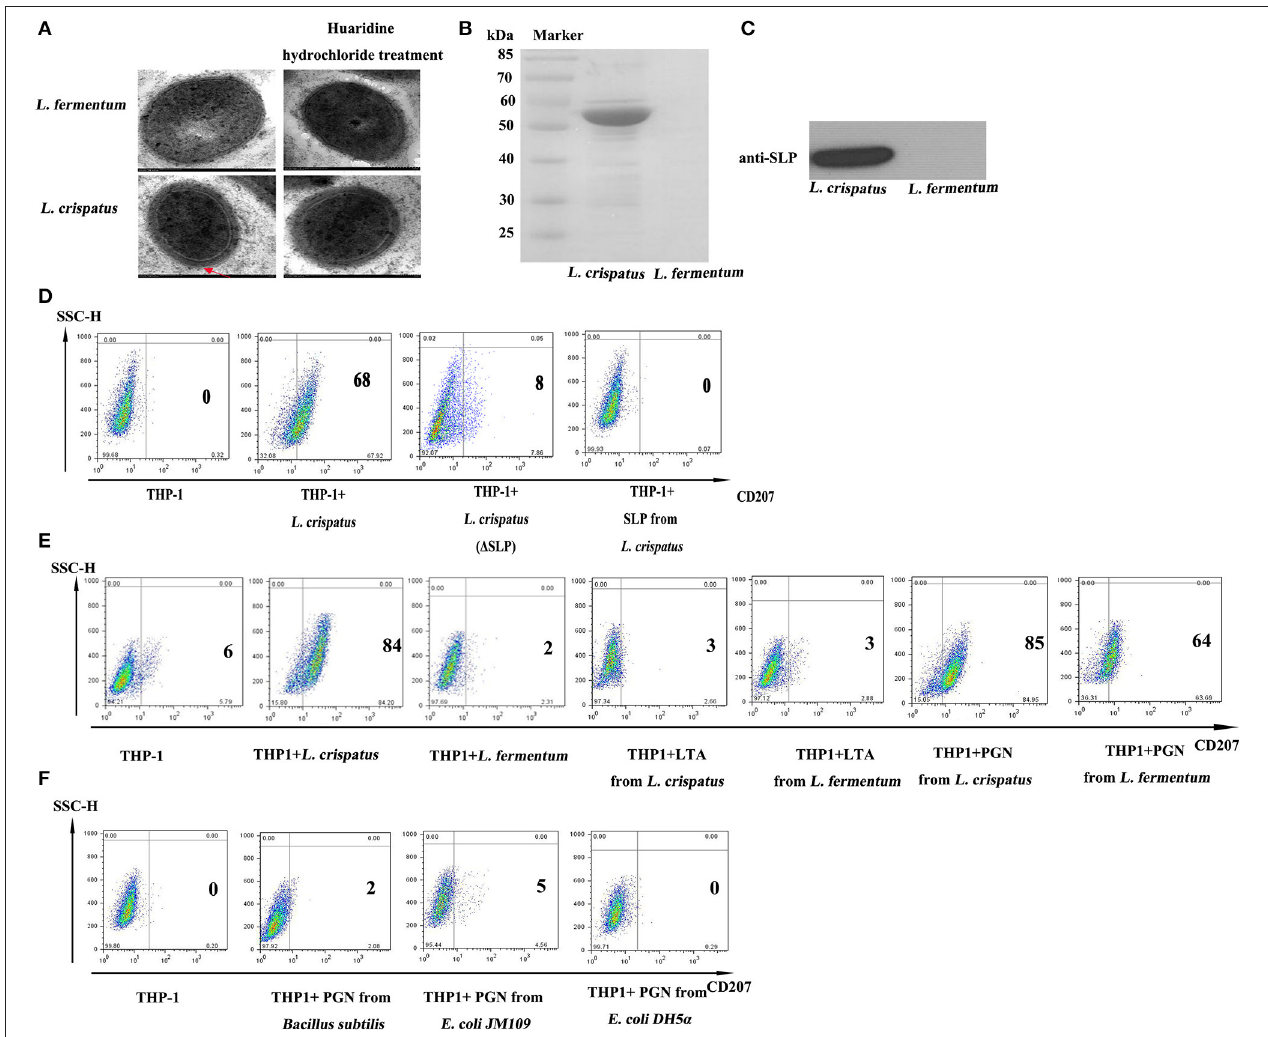
FIGURE 7 | The function of SLP, f PGN and LTA in regulating the expression of CD207 on THP-1. (A) The structure of L. crispatus and L. fermentum were observed by transmission electron microscopy (TEM). L. crispatus and L. fermentum untreated and treated with huaridine hydrochloride were observed by TEM with high magnification. (B) Detection of SLPs from L. crispatus and L. fermentum by SDS-PAGE. (C) Identified SLPs from L. crispatus and L. fermentum by WB. The target protein is about 55 kDa. (D) CD207 expression induced by SLP from L. crispatus. Cells were treated with 1 mg/ml SLP from L. crispatus and L. fermentum . (E) CD207 expression induced by PGN and LTA from L. crispatus and L. fermentum . Cells were treated with 1 mg/ml PGN or LTA from L. crispatus and L. fermentum . (F) CD207 expression induced by PGNs from Bacillus subtilis , E. coli JM109 and E. coli DH5 α . Cells were treated with 1 mg/ml PGN o from Bacillus subtilis , E. coli JM109, and E. coli DH5 α